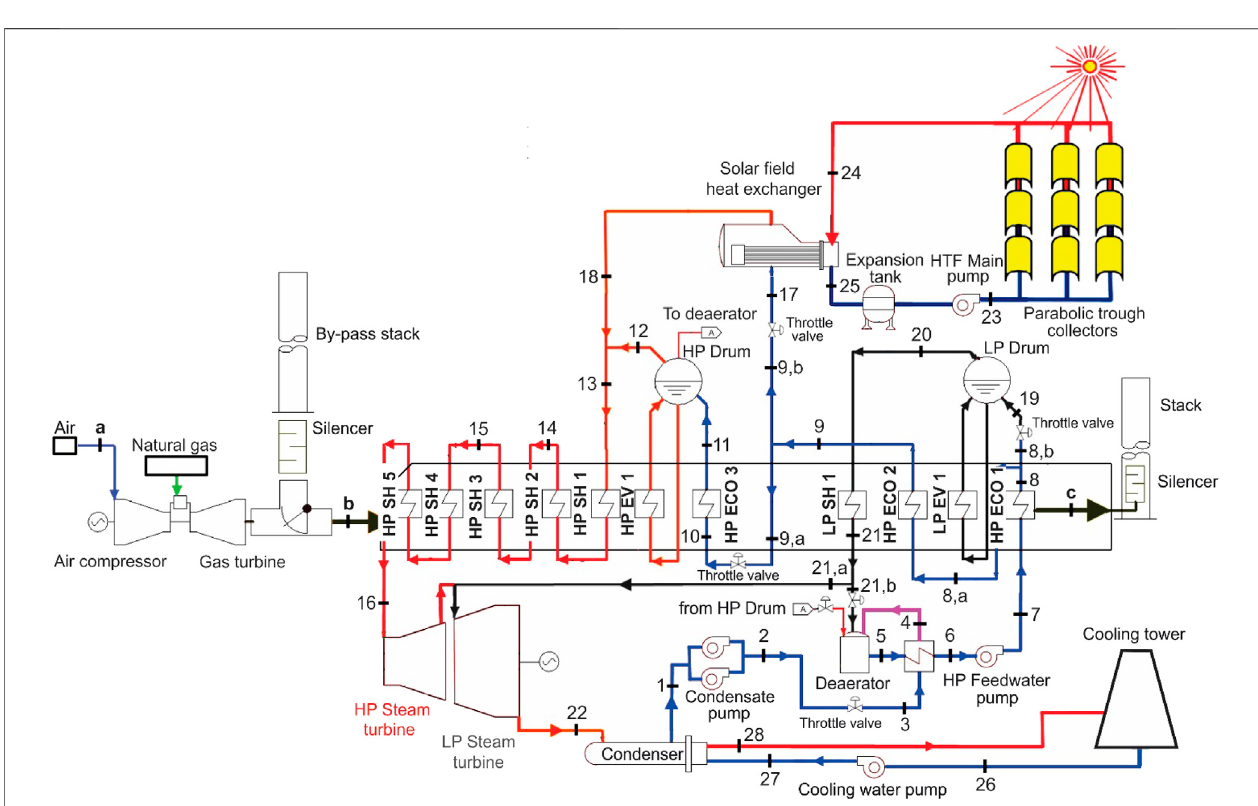
FIGURE 4 | Schematic diagram of an ISCC power plant (source (Rashad et al., 2021; Temraz et al., 2020b)).